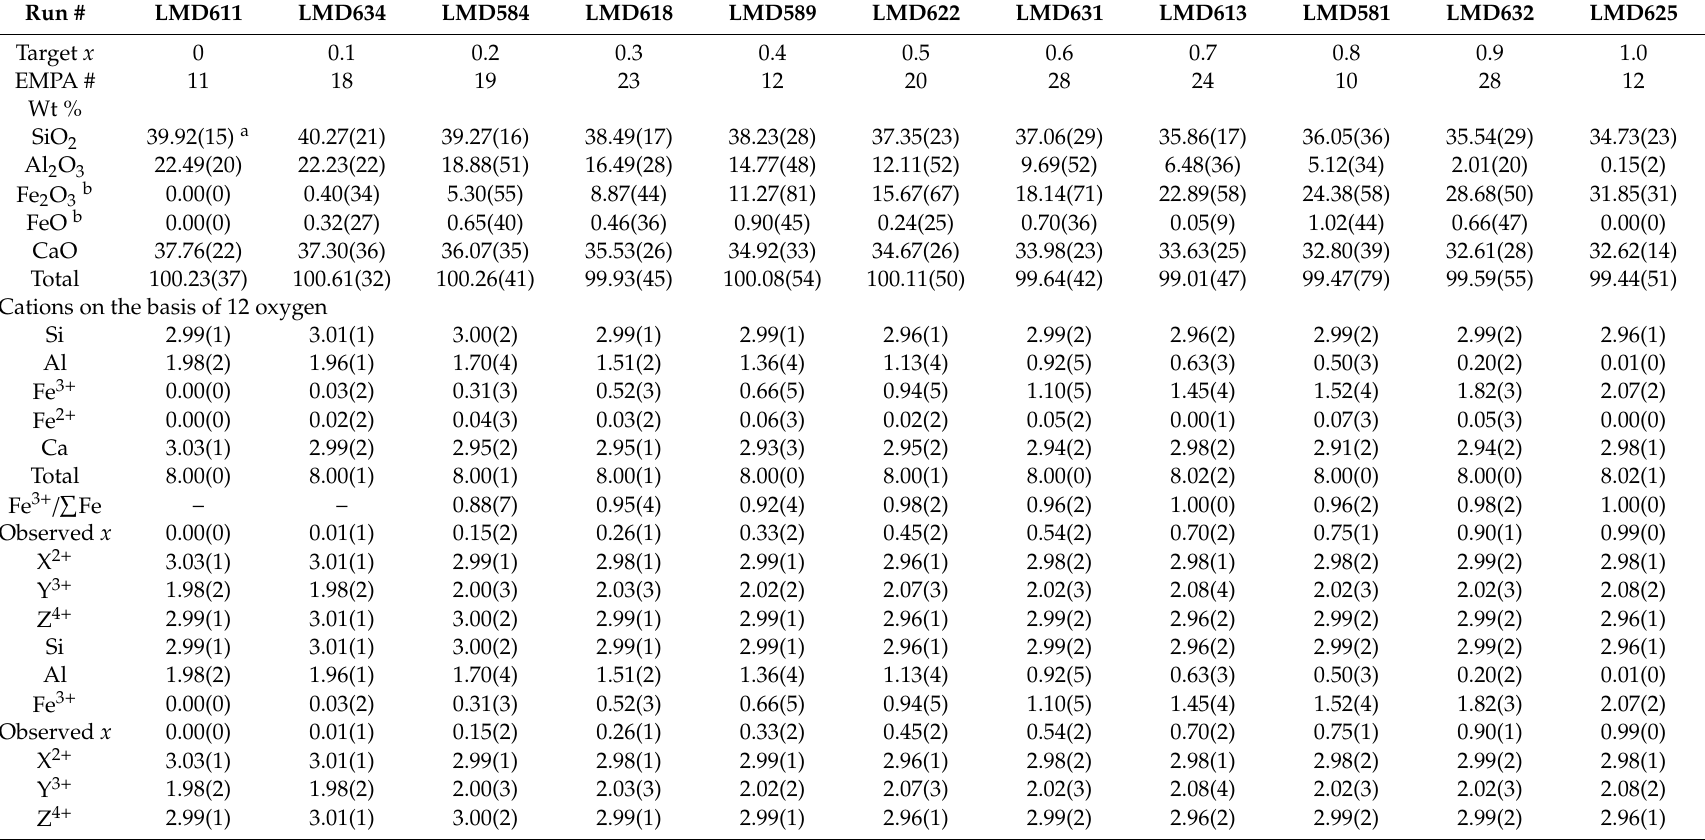
Table 4. Compositions of